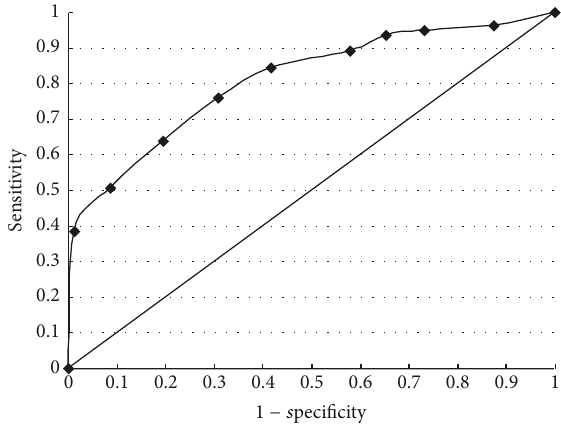
Figure 3: ROC statistics of the maximum entropy model.